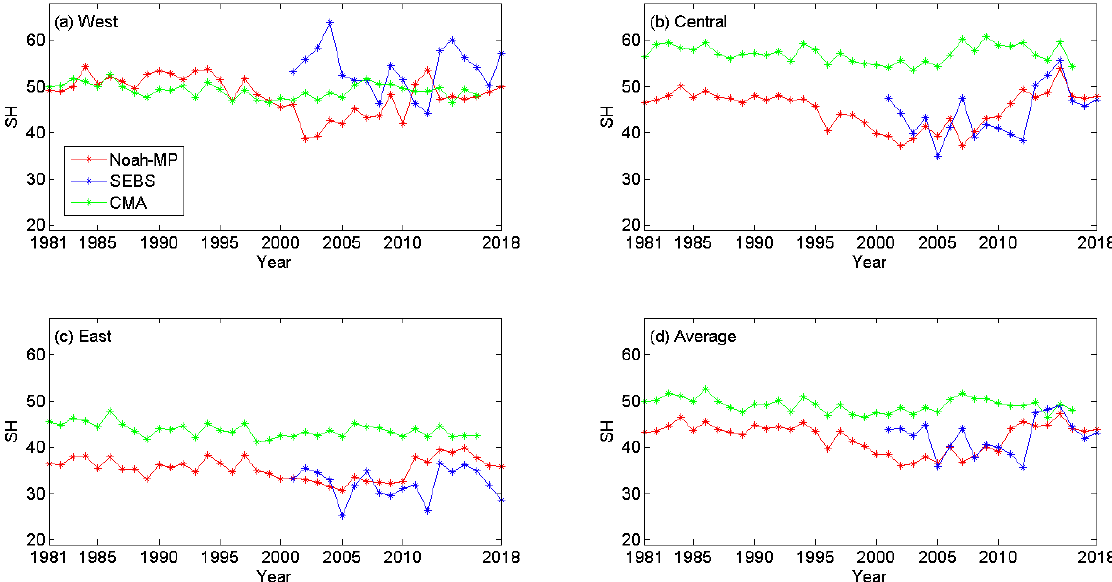
Figure 5. Variations in annual mean SH flux (Wm −2 ) from Noah-MP, SEBS, and CMA data for the western ( a ), central ( b ), eastern ( c ), and entire TP ( d ) during the period 1981 –